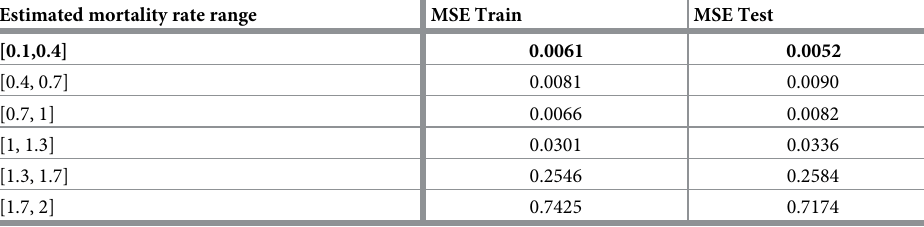
Table 9. Total mean square error (MSE) of training and testing data in the best implementation of the ANN-BTA network for estimating the mortality rate of COVID-19 patients in the ranges of [0.1,0.4], [0.4,0.7], [0.7, 1], [1.1.3], [1.3,1.7] and [1.7,2]. Estimated mortality rate range